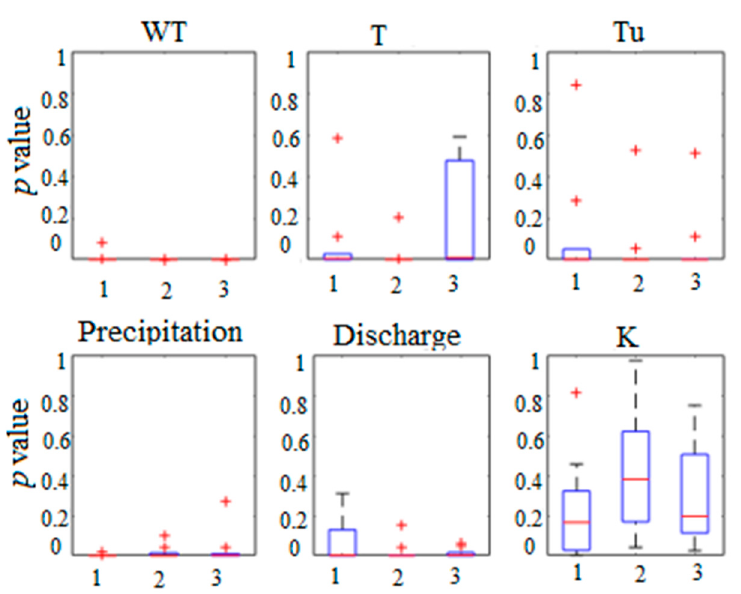
Figure 8. Same as in Figure 7, but for DO as an effect in the Granger causality relationship. When Tu is the effect (Figure 9), the Granger causality relationships are strong